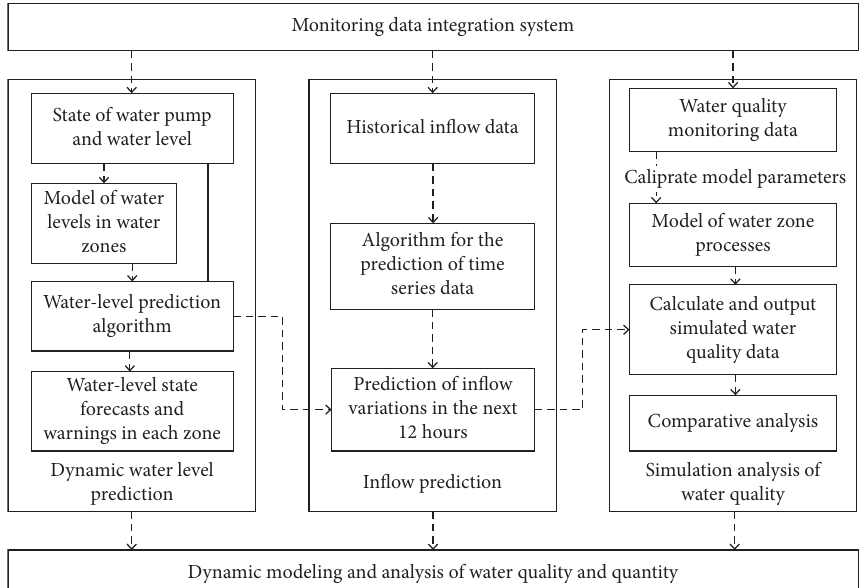
Figure 5: Dynamic water-quality and water-quantity modeling and analysis.